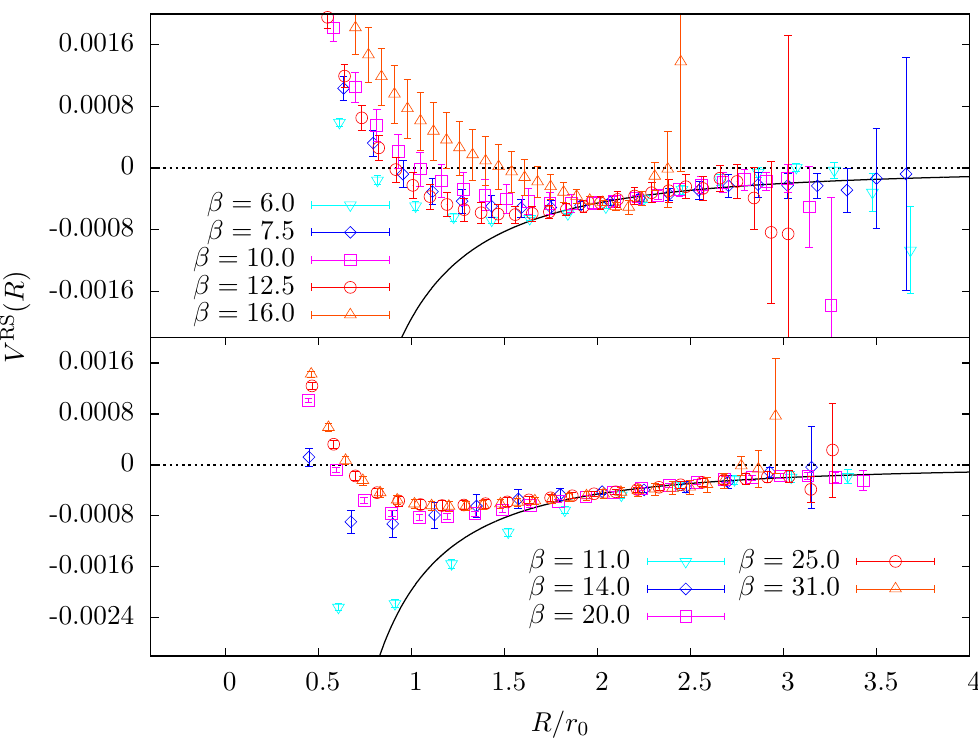
Figure 3 . Results for the static potential (in its rescaled form | see eq. (3.4)) for di(cid:11)erent lattice spacings versus R in SU(2) (top) and SU(3) (bottom) gauge theory. The black continuous line is the light cone potential from eq. (2.7) using the continuum extrapolated string